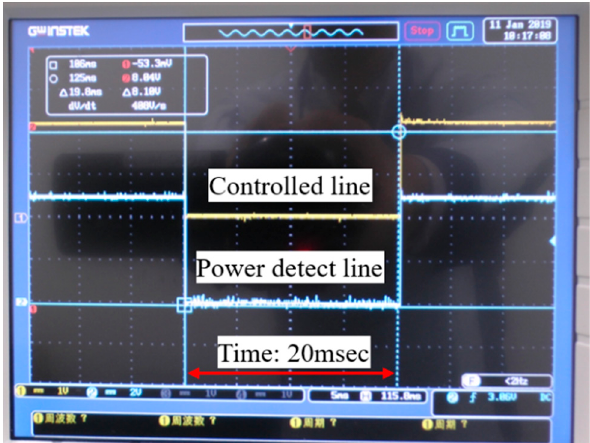
Figure 14. Measured PWM output waveform.